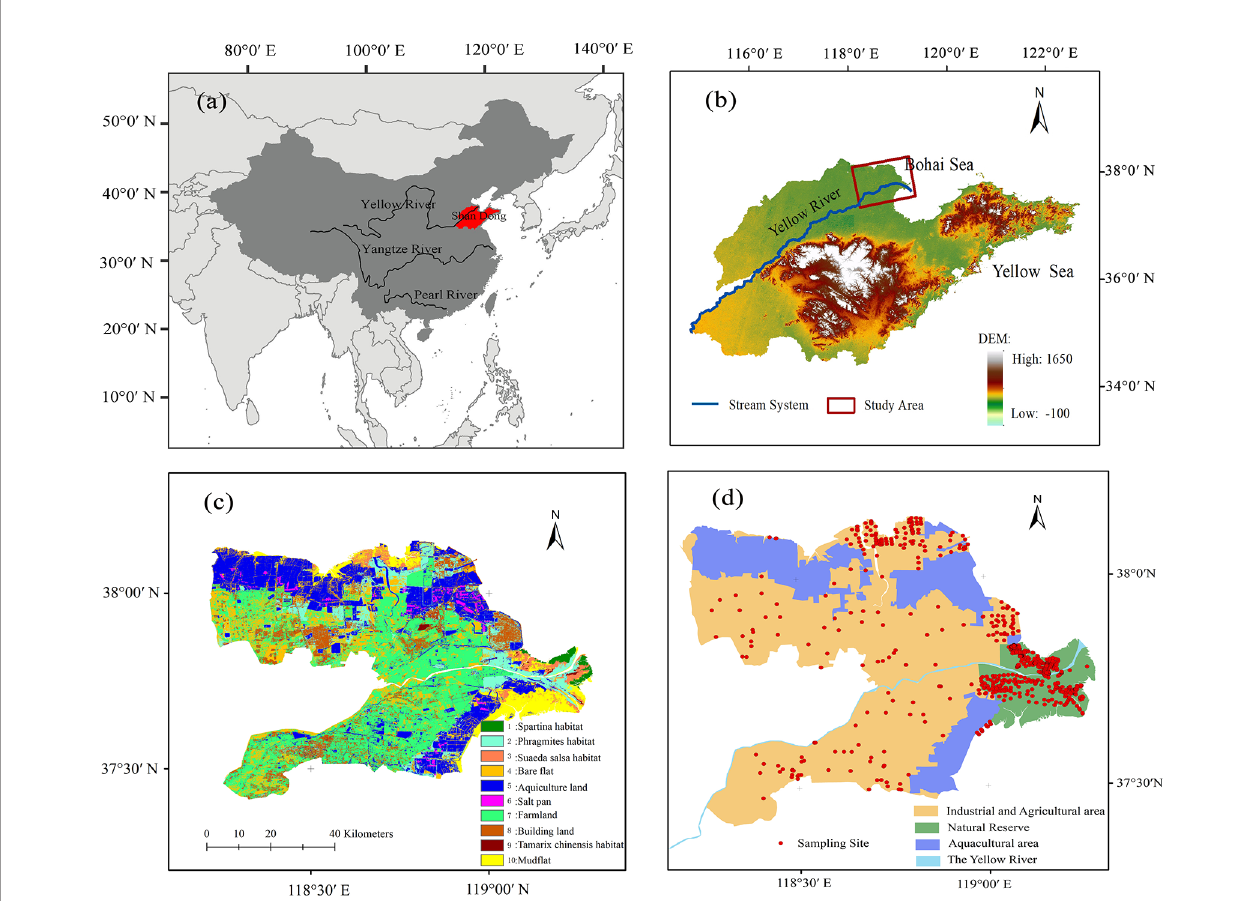
FIGURE 2 | Location of the Yellow River delta, China. (A) Map of China, (B) digital elevation map of Shandong, (C) land use cover types for 2016 from the Landsat 8 OLI image at 30-m spatial resolution, and (D) sampling points (red dots) in the Yellow River